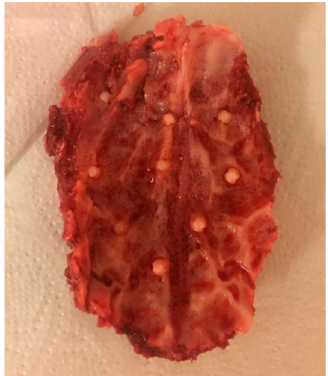
Figure 7. Extracted frontal calvarial bone of a landrace pig after a healing time of four weeks.